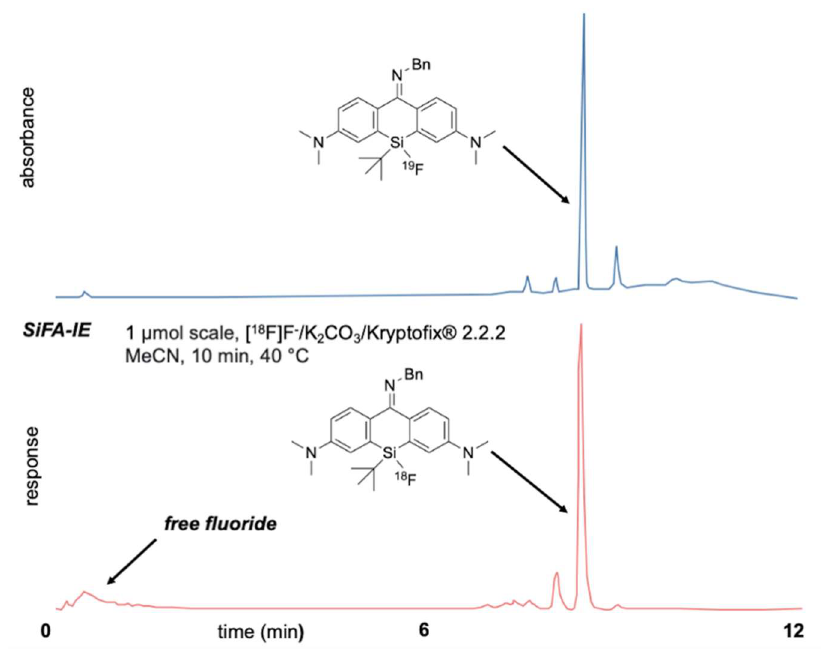
Figure 7. Successful SiFA-IE of [ 19 F] 31 with azeotropic dried [ 18 F]KF: the radiolabeled pyronine [ 18 F] 31 could be clearly detected by (radio-)HPLC (lower graph), the non-radioactive compound (crude, due to instability during chromatography) was used as a reference (upper graph) (see Supplementary Materials for details). The side-products were not characterized.